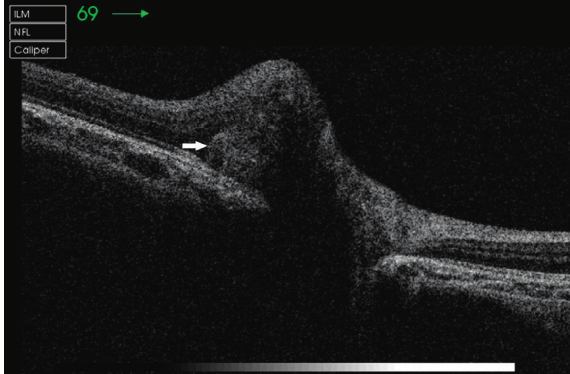
Figure 4: OCT of a patient with ODD. High-reflex dense points with different volumes of quasicircular shadows can be observed in the optic papillary nerve fiber layer. The white arrow indicates